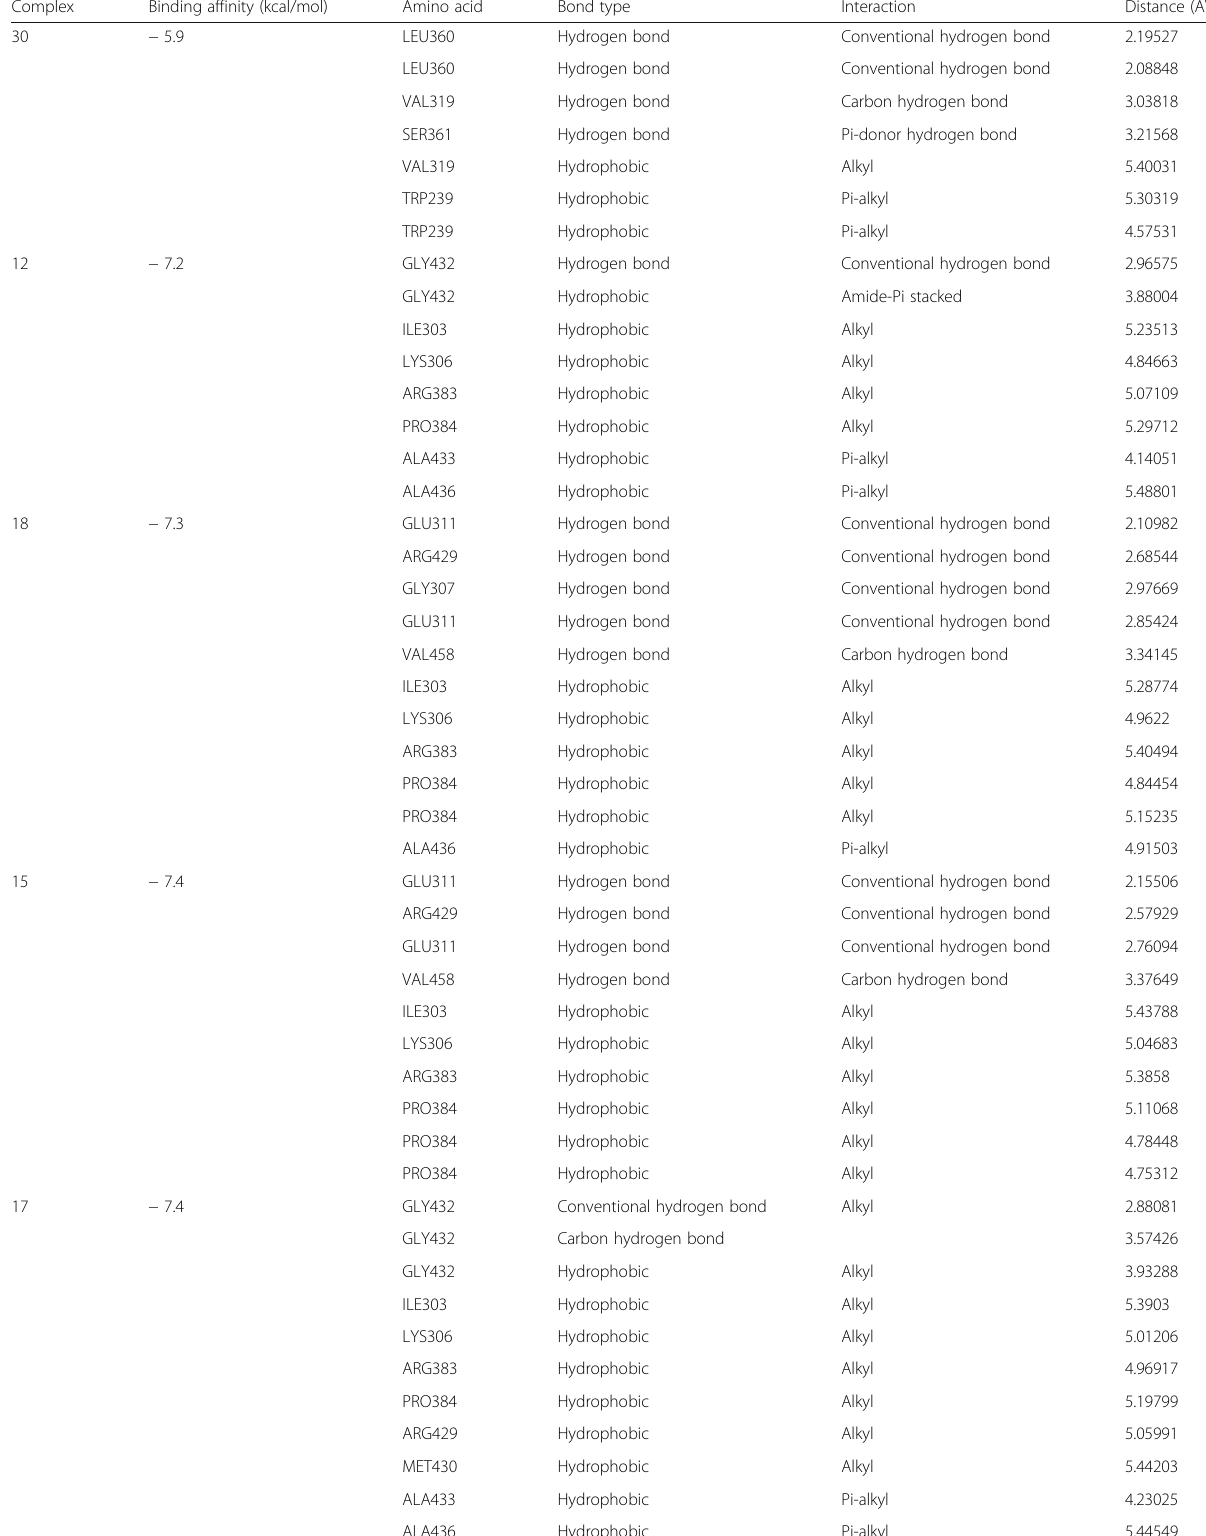
Table 2 Binding affinities, interaction types, bond types, and bond distances between some compounds and the receptor Complex Binding affinity